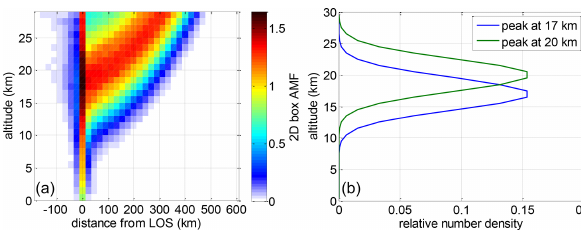
Figure A1. (a) 2D box AMFs for a clear-sky atmosphere. (b) Rel- ative OClO number density profiles used for the sensitivity